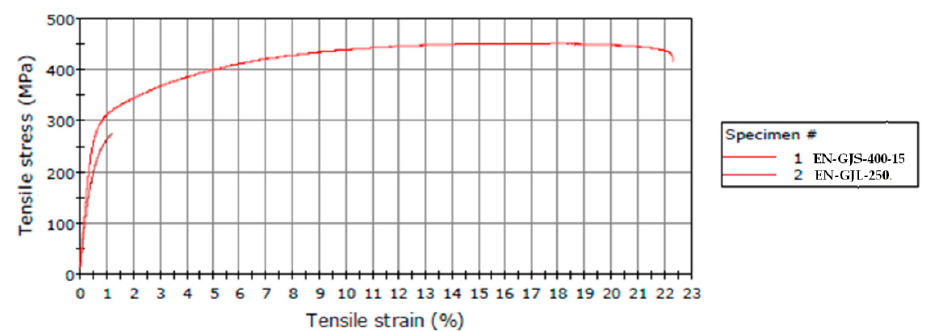
Figure 16. Variation of the tensile strength as a function of elongation at failure in the case of the two testing samples representing the average values of the tests.